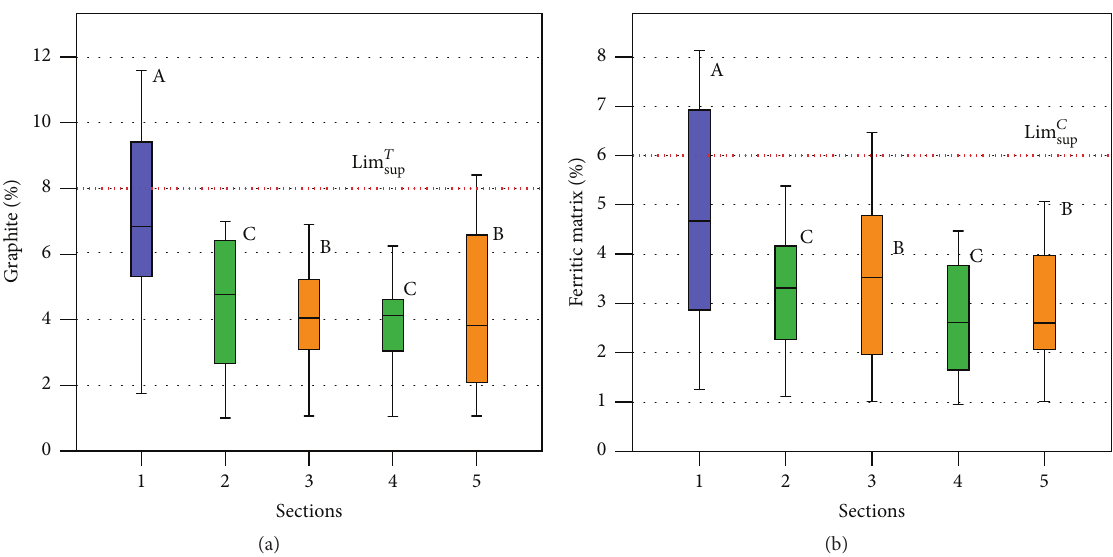
Figure 10: Classification of the sections according to the first phase of the section classifying algorithm: (a) sizes of the nodules; (b) separation distances between the nodules.